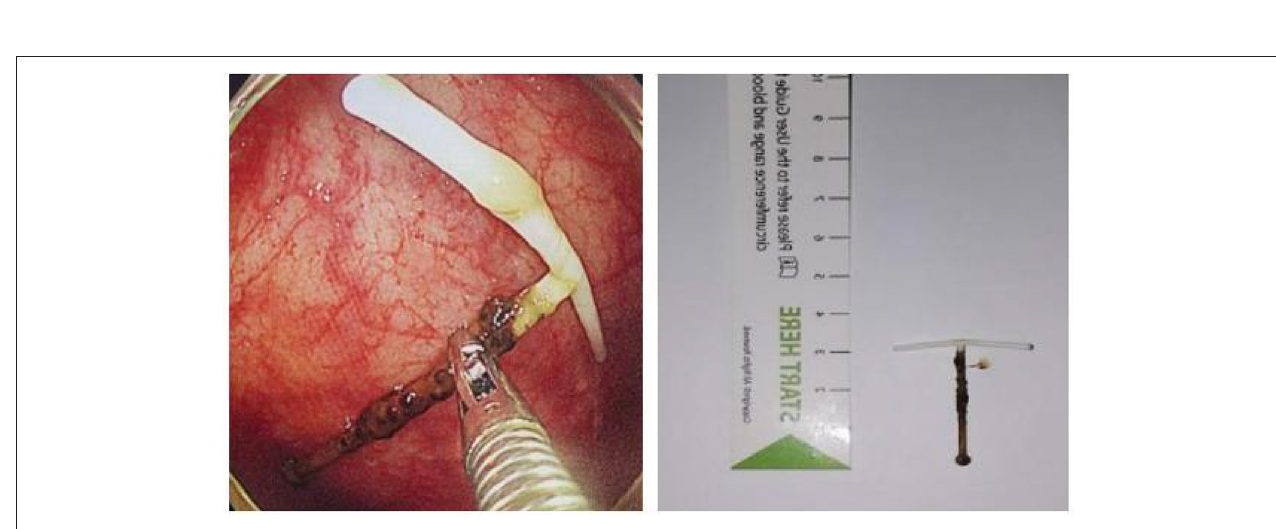
FIGURE 3 | The IUD was removed